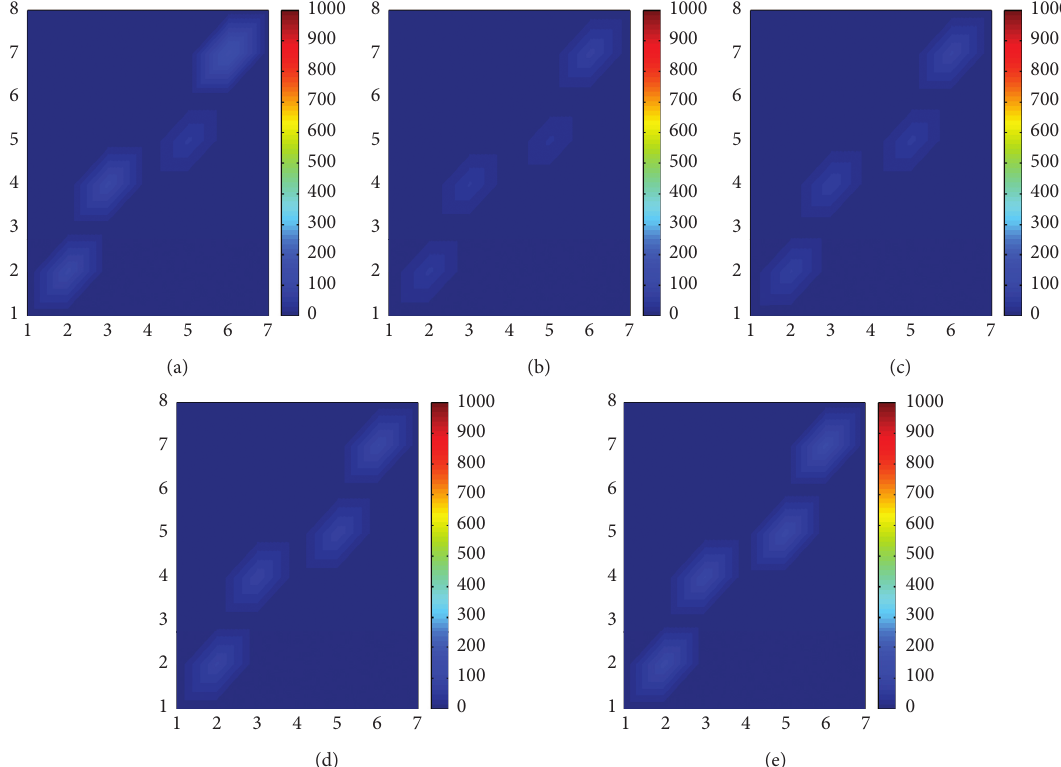
Figure 12: The biomass of top predator behavior within Ω with control u C pq and v C pq . (a) t � 0. (b) t � 50. (c) t � 100. (d) t � 150. (e) t �